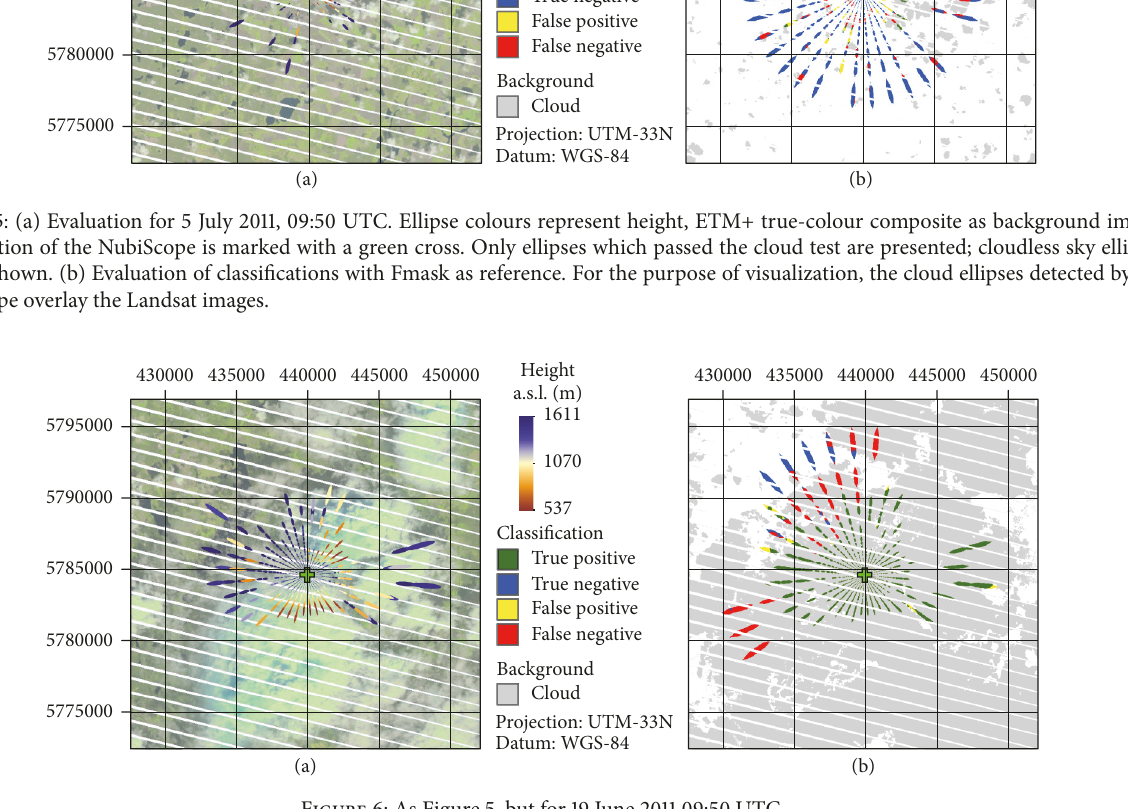
Figure 6: As Figure 5, but for 19 June 2011 09:50